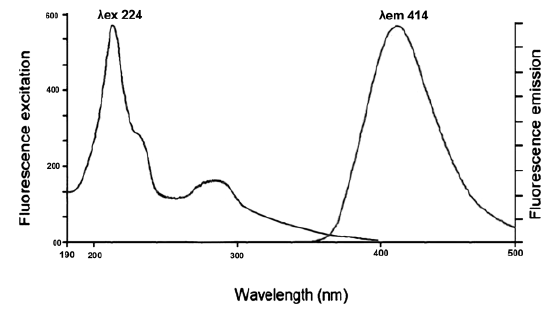
Fig.3. Effect of different diluting solvents on fluorescence intensity of Baricitinib.